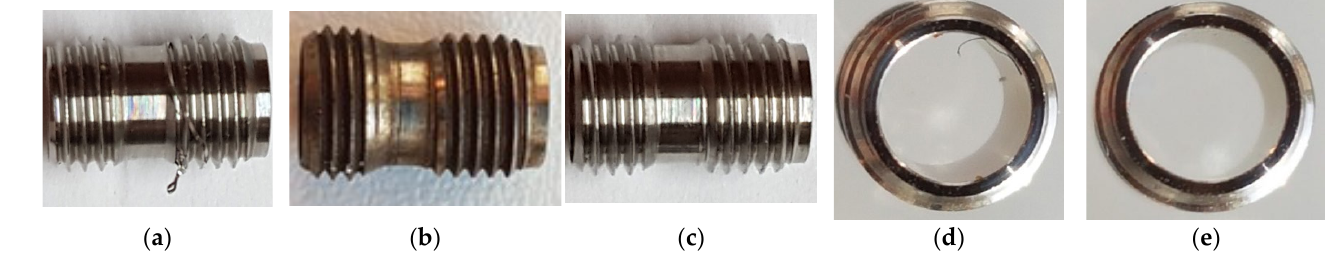
Figure 4. Removal of burrs from the parts made of the 29 NK alloy in the Pulsar VKF 3.250 thermal pulse installation: ( a , d ) the part with long burrs (the dimensions are D = 6 mm, L = 10.2 mm) before processing; ( b ) the part with a burr with a root thickness of 0.1 mm after processing at P = 1.8 MPa; the surface is scorched, the edges of the thread are rounded, and the burr is removed; ( c , e ) the part after processing in the rational mode with burrs removed and surface quality and dimensions preserved.